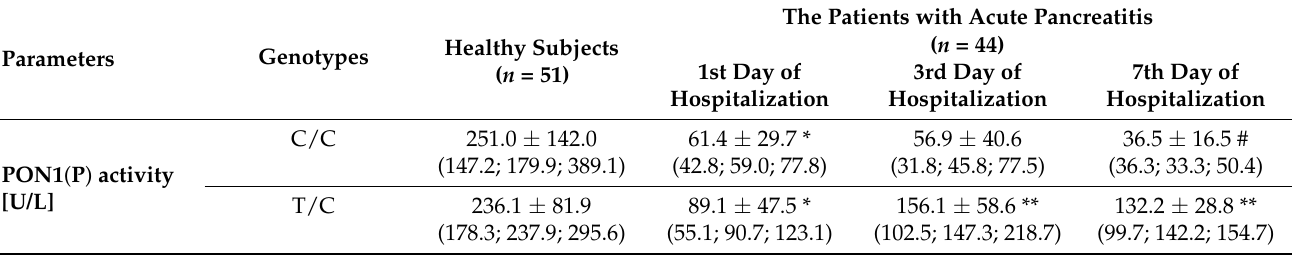
Table 6. PON1 activities, its concentration, the concentration of apoA-I, lipid profile, and selected markers of pro/antioxidative balance in the context of genotypic variability of SNP +83 bp in the APOA1 gene in the group of healthy subjects and AP